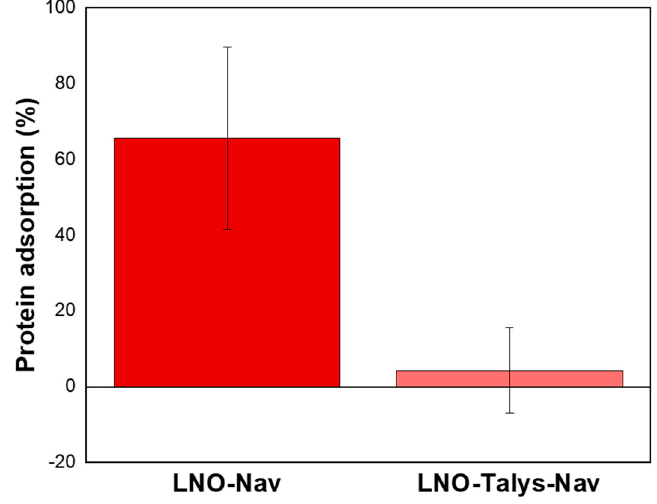
Figure 6. Protein adsorption (%) on bare LNO NPs and LNO@Talys NPs. Results are expressed as mean ± SD (triplicates).